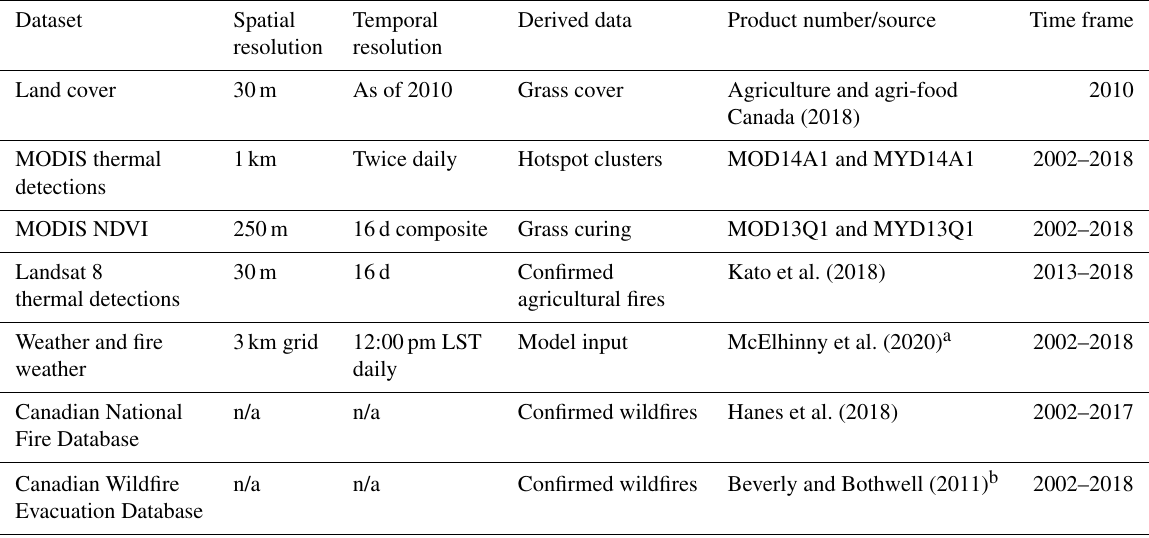
Table 1. Summary of datasets used in study.